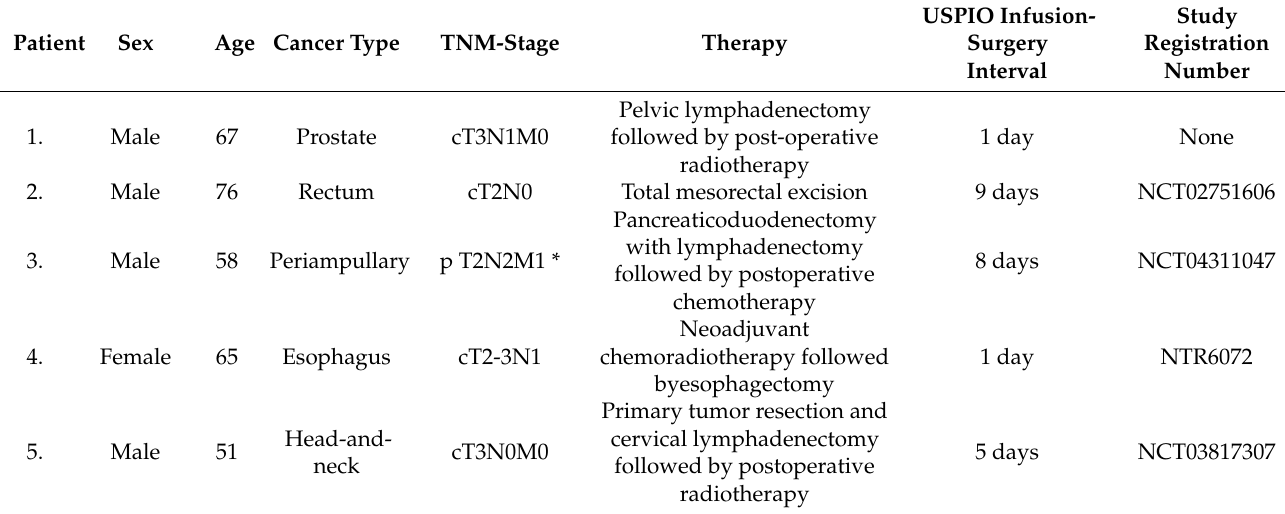
Table 1. Patient